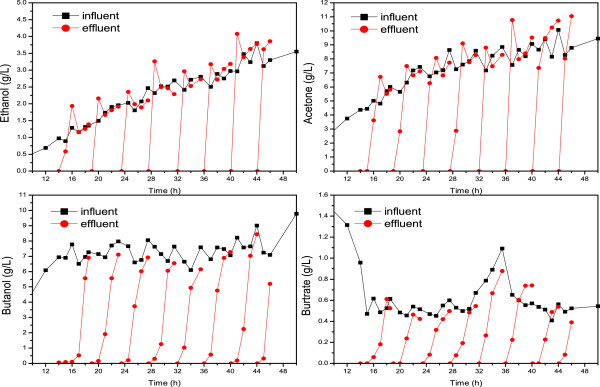
Kinetics of the fixed-bed adsorption. The fixed-bed adsorption was started at13 h. A sample before the adsorption (influent, black square) and a sample after the adsorption (effluent, red circle) were withdrawn simultaneously every time to determine the extent of resin saturation. A higher sorbate titer in the effluent meant that the sorbate initially adsorbed onto the KA-I resin was subsequently eluted in the butanol adsorption process. The resin column was replaced with a new resin column when saturated by butanol.